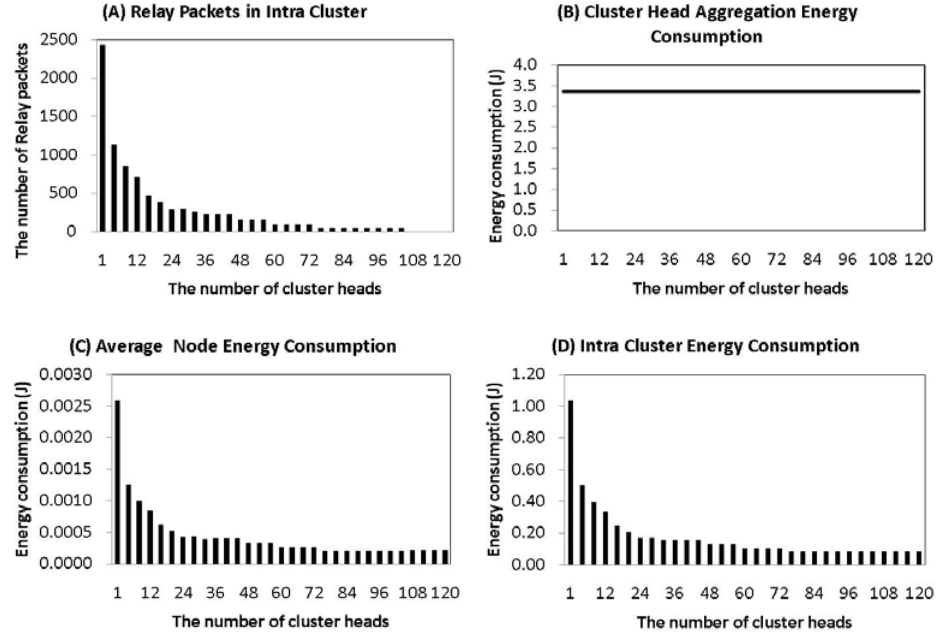
Figure 2. Intra-Cluster. (A) relay packets in intra-clusters, (B) cluster-head aggregation energy consumption, (C) average node energy consumption, (D) intra-cluster energy